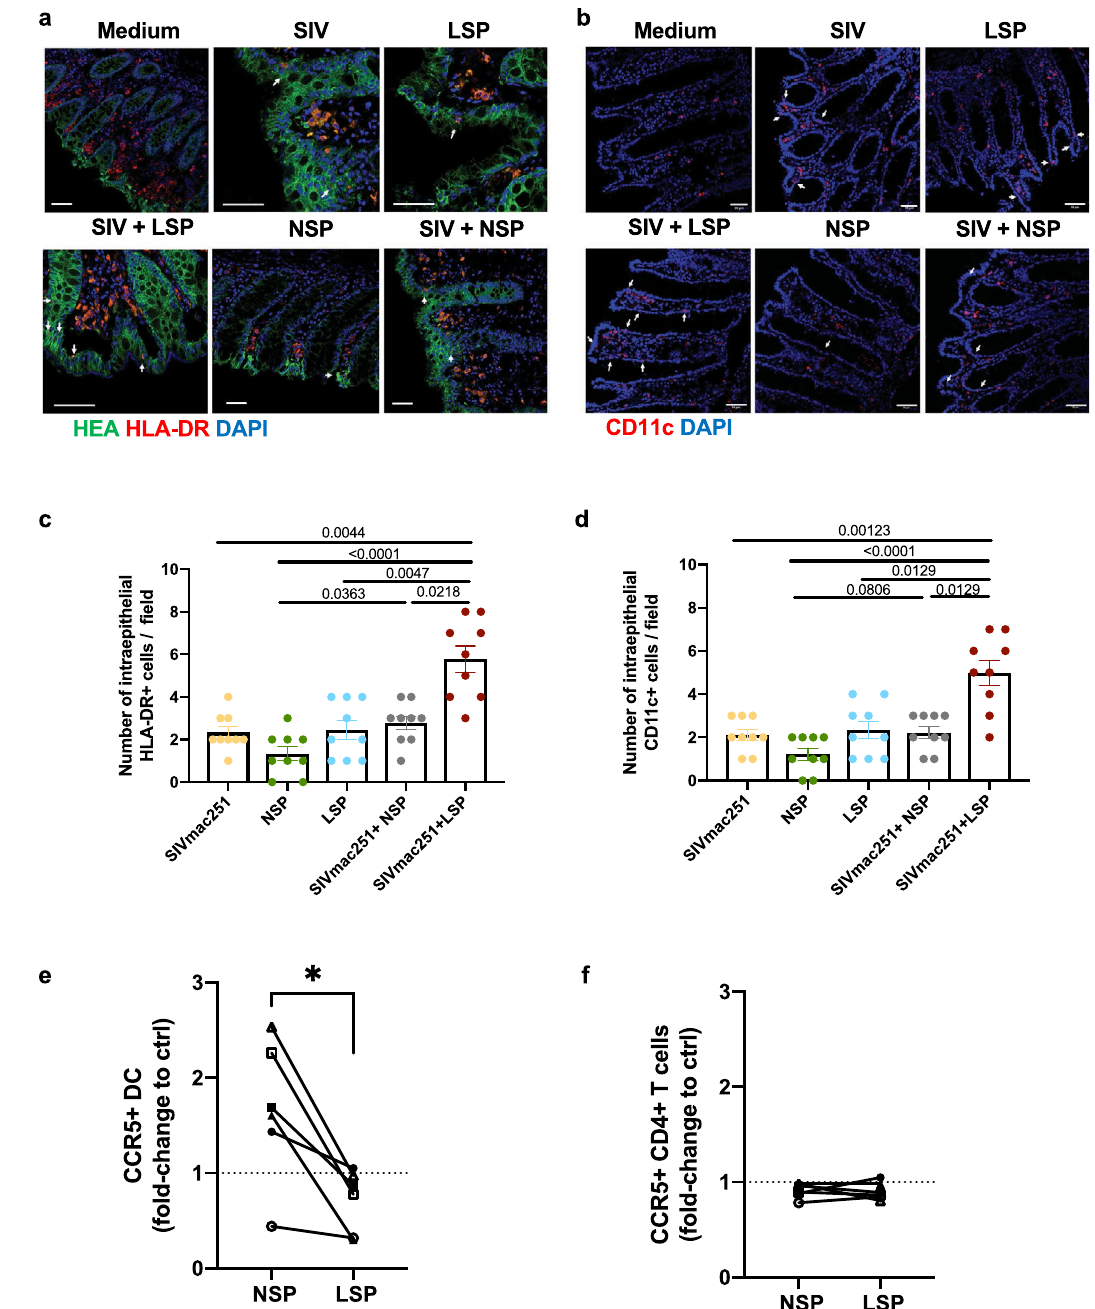
Fig. 7 Seminal plasma favors dendritic cell migration inside the colonic epithelial barrier. a , b Immuno fl uorescence staining for the human epithelial antigen (HEA-FITC, green), HLADR + cells (red, a ), and CD11c + cells (red, b ) after 1.5 h of treatment of the macaque colonic explant with medium, SIVmac251, 25% LSP, SIVmac251 + 25% LSP, 25% NSP, or SIVmac251 + 25% NSP. Nuclei are stained with DAPI. Arrows point to intraepithelial HLA-DR + or CD11c + cells. Scale bar = 50 µ m. c , d Quanti fi cation of the number of HLA-DR + cells ( c ) and CD11c + cells ( d ) present inside the intestinal epithelium following exposure to the different stimuli. Bars represent the mean ± SD of three randomly chosen fi elds from three different experiments. Statistical signi fi cance between the different conditions was tested using Kruskal – Wallis tests with post hoc Benjamini, Krieger, and Yekutieli tests. e , f Lamina propria mononuclear cells isolated from 6 different donors were incubated 2 h with medium, 25% NSP or 25% LSP, washed, and immunophenotyped 6 h later. Percentage of CCR5 + HLA-DR + CD11c + DC ( e ) and CCR5 + CD4 + T cells ( f ) exposed to NSP and LSP is expressed as fold change compared to the control (medium). p < 0.05 denotes signi fi cant difference between conditions (Friedman tests with post hoc Benjamini, Krieger, and Yekutieli